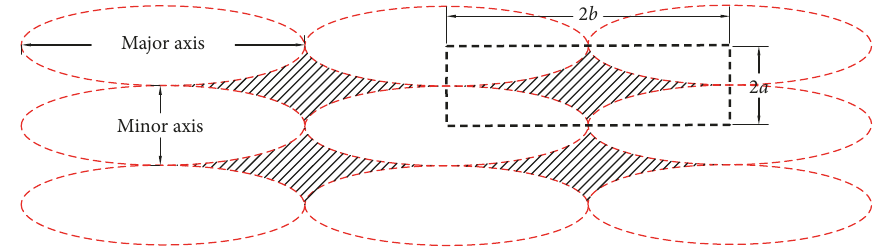
Figure 7: Projection of vertical seepage tube in XY